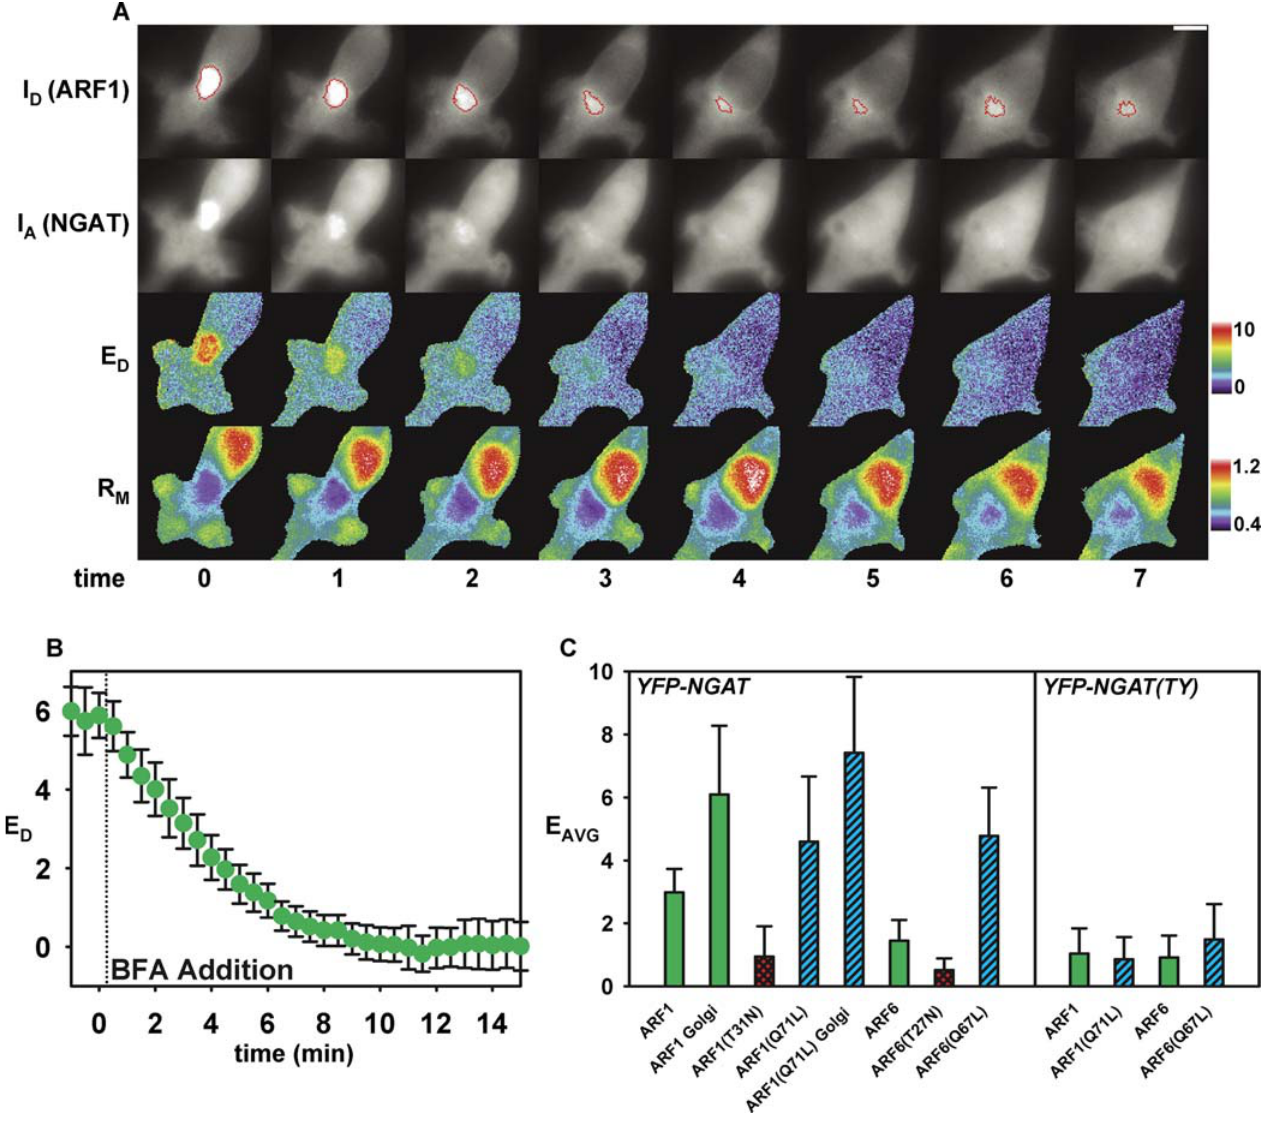
Figure 1. Measurement of ARF Activation Using FRET Stoichiometry (A) Time points (in minutes) are relative to the addition of 5 l m BFA. ARF1-CFP and YFP-NGAT were enriched at the Golgi complex in transfected RAW264.7 macrophages. BFA rapidly disintegrated the Golgi network (shrinking region outlined in red in the ARF1-CFP panels), and the fluorescent markers redistributed to the cytosol. Color bars to the right of the E D and R M panels indicate the magnitude of E D expressed as a percent, and the molar ratio of YFP-NGAT/ARF1-CFP, respectively. The values to the right of the color bar indicate the values of the pixel colors at the ends of the scale. For each image series and video presented in this work, all images within a single time series are identically scaled and directly comparable. Note that in the region of the Golgi apparatus, ARF1-CFP was present at an ; 2.5-fold molar excess relative to YFP-NGAT. YFP-NGAT localization to the Golgi apparatus was mediated by ARF1-GTP binding as indicated by the high E D values at the Golgi. The FRET-based detection of ARF1-activation rapidly decreased after the addition of BFA; nearly all ARF1 activation was blocked within ; 5 minutes of the addition of BFA. The scale bar located in the upper right of the CFP time series is 6 l m. (B) The decrease in E D signals at the Golgi apparatus corresponding to loss of active ARF1 was quantified. An inclusive threshold was used to generate regions (as shown in the ARF1-CFP panels above) and to mask the E D image to measure the Golgi-associated activation of ARF1 after BFA addition. Following the addition of BFA (dotted line), ARF1-GTP levels at the Golgi immediately began to decrease; n ¼ 6 cells. Error bars represent 6 the standard error of the mean (SEM). (C) FRET values expressed as the average of the percent E A and E D signals were measured in macrophages expressing the indicated FRET partners. The dominant-negative ARF-CFP chimeras produced low, but detectable, FRET signals when co-expressed with YFP-NGAT. Conversely, co-expression of the constitutively active ARF1(Q71L)-CFP or ARF6(Q67L)-CFP chimeras with YFP-NGAT produced elevated FRET signals compared with wild-type ARF-CFP chimeras. ARF1(Q71L)-CFP and YFP-NGAT generated slightly elevated FRET signals at the Golgi apparatus. The bar plots to the right of the black line are FRET signals measured when the listed ARF-CFP chimera was co-expressed with YFP-NGAT(A193T, N194Y), an NGAT molecule with reduced ARF-GTP binding affinity. Neither the wild-type nor constitutively activated ARF-CFP chimeras generated high FRET signals when co-expressed with YFP- NGAT(A193T, N194Y). Measurements for each FRET pair are the average from at least 25 cells, and error bars represent plus/minus the standard deviation. DOI: 10.1371/journal.pbio.0040162.g001